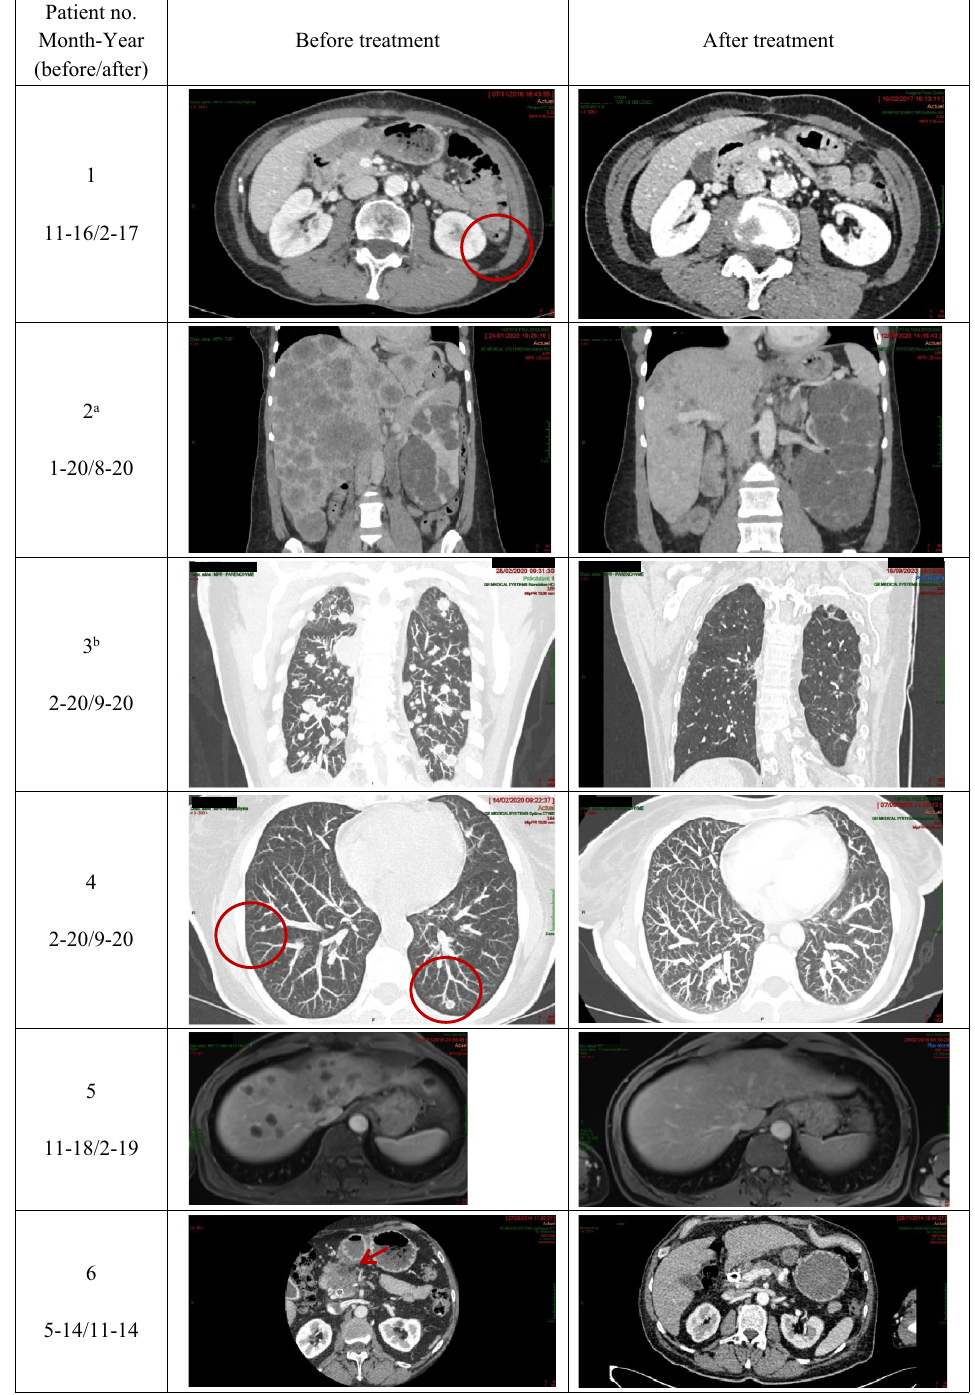
Table 3. Selected iconography of the 11 responders to regimens comprising 5-fluorouracil, folinic acid, and pyridoxine in tandem. Patients are numbered in the same order as in Tables 1, and 2, Fig. 2, and Fig. 3 a Presence of polycystic kidneys. b Presence of CoViD-19 pneumonia-related images in CT scan after